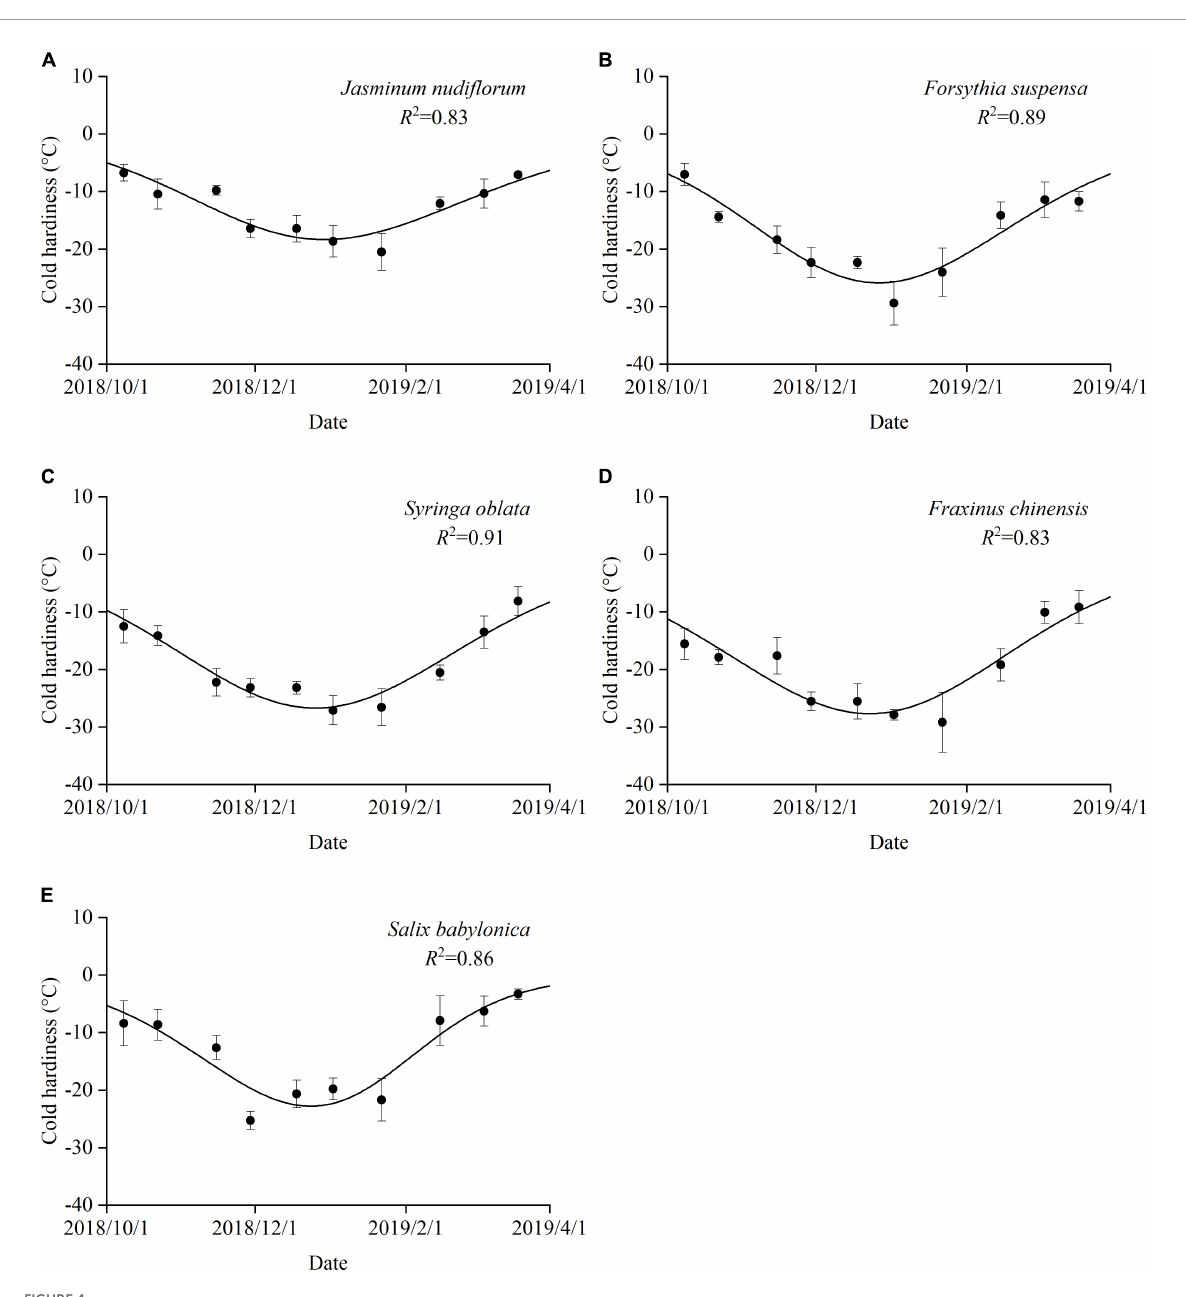
FIGURE4 Seasonal variations in cold hardiness for five species. Error bars: standard deviation. R 2 : coefficient of determination for the double logistic function. (A) J. nudiflorum , (B) F. suspensa , (C) S. oblata , (D) F. chinensis , and (E) S. babylonica